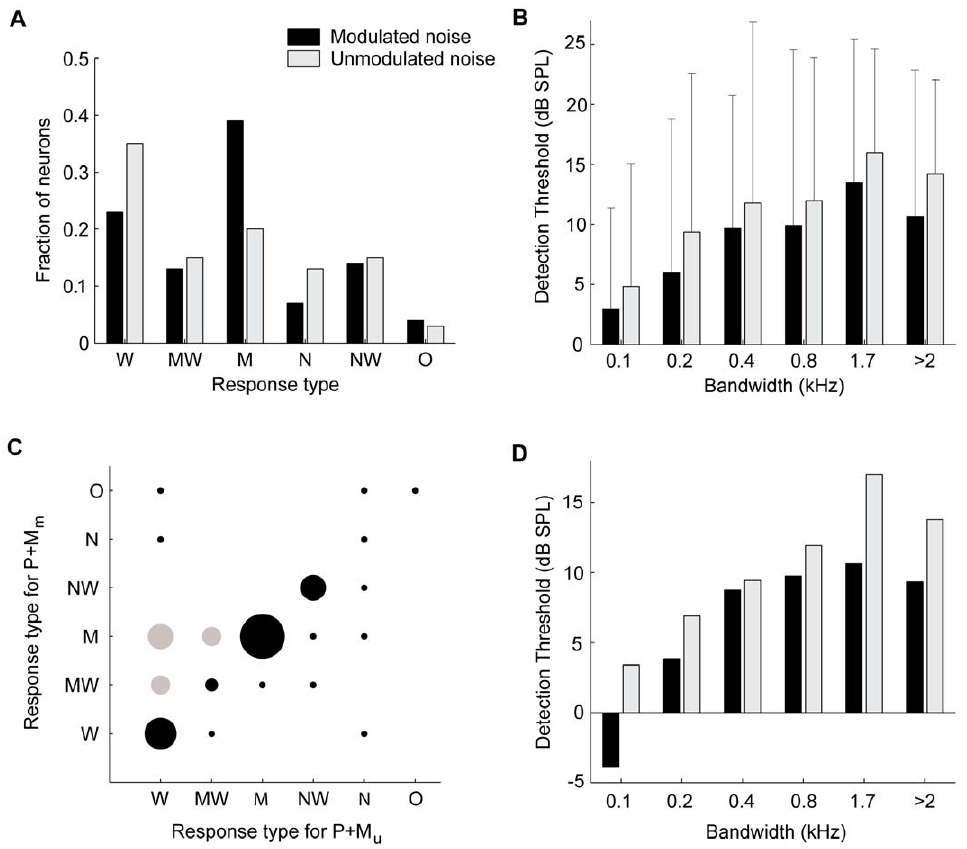
Figure 8. Population characteristics of the responses to P + M m and P + M u . A: Distribution of the different response functions (see Fig. 7) for P + M m (black) and P + M u (gray). ‘O’ indicates other types of responses. B: Median threshold increase ( DT P z M (gray), as a function of masker bandwidth. Errorbars indicate interquartile ranges; large interquartile ranges point to the high variability in the neural responses. C: Relative occurrence of the different types of threshold curves for P + M m (ordinate) and P + M u (abscissa). The size of the dots indicates the percentage of neurons, with the largest dot corresponding to 17.5%. Combinations that can lead to CMR-type behavior are indicated in gray. D: Median detection thresholds for M m (black) and M u (gray) for the off-diagonal neurons (gray circles) in C .